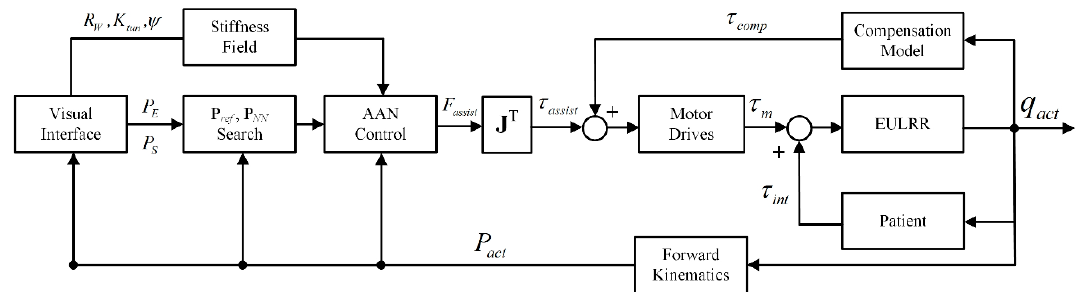
Figure 7. The control chart of the AAN controller.